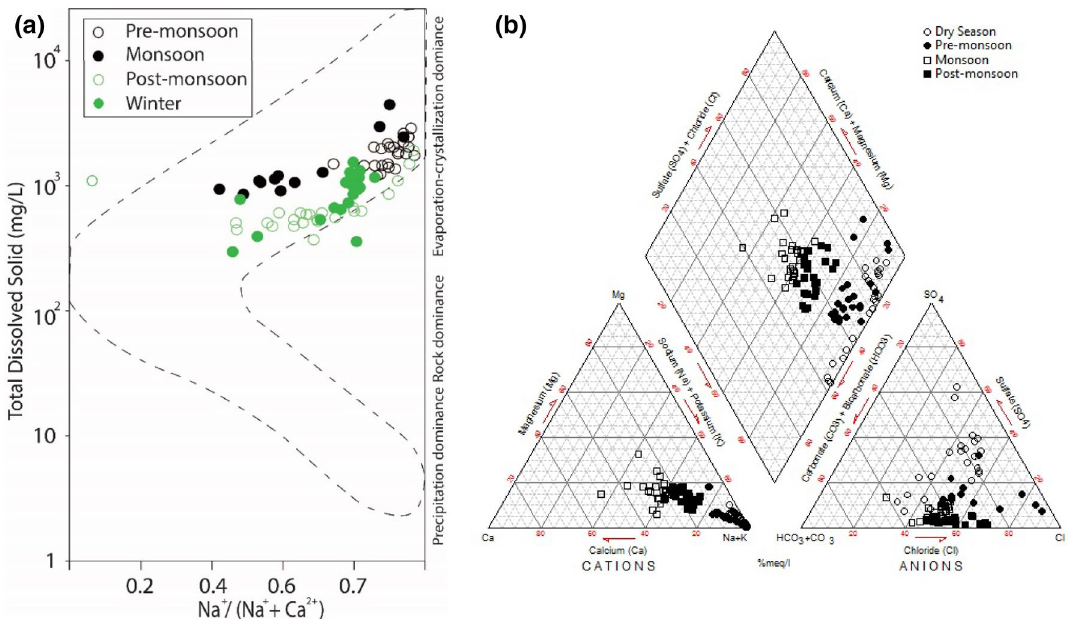
Fig. 4 a Na + /(Na + + Ca 2+ ) versus total dissolved solids (TDS), after Gibbs (1970); b Piper trilinear diagram (Piper 1944) showing ion composi- tion over the sampling